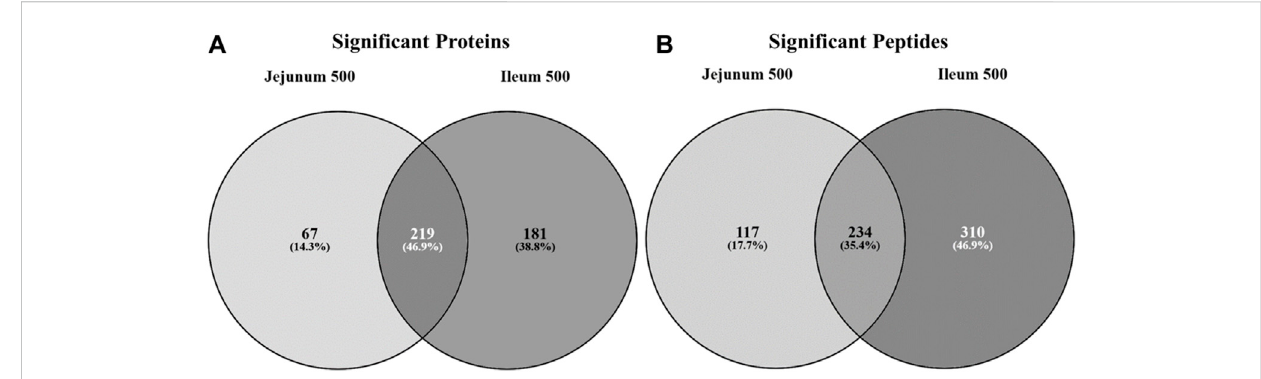
FIGURE 1 Venn diagram ofsigni fi cantly differentially phosphorylated proteins and peptides in ileumand jejunumfrom birds provided feedsupplemented with 500 g/MT of a microencapsulated blend of organic acids and botanicals compared to their respective controls fed a non-supplemented diet at 15 days post-hatch.Kinasetargetpeptidesareprintedonthearrayandarephosphorylatedbyactivekinases;therearemultiplepeptidespresentonthearrayfora given protein. Proteins (A) and peptides (B) statistically signi fi cantly differentially phosphorylated in jejunum and ileum from birds fed product containingfeed( p < 0.05)fromtheirrespectivecontroltissuewereinputintotheVenndiagram-generatingprogramVenny(http://bioinfogp.cnb.csic.es/